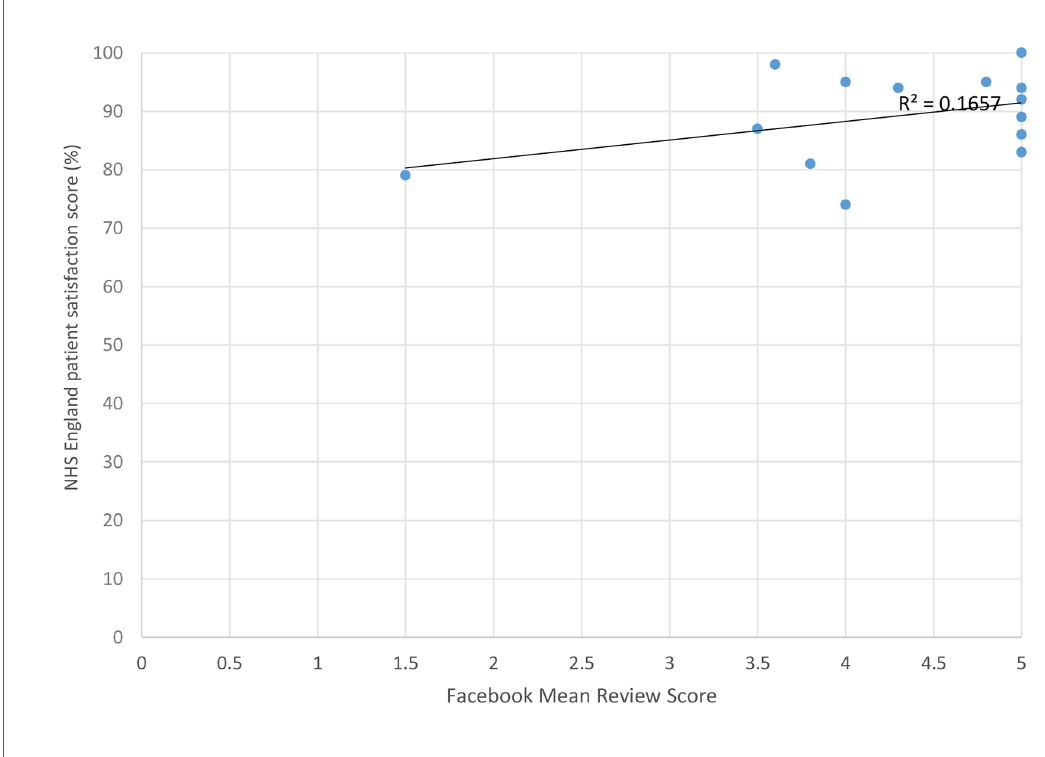
Figure 2. NHS England Patient Satisfaction score (%) versus official Facebook review